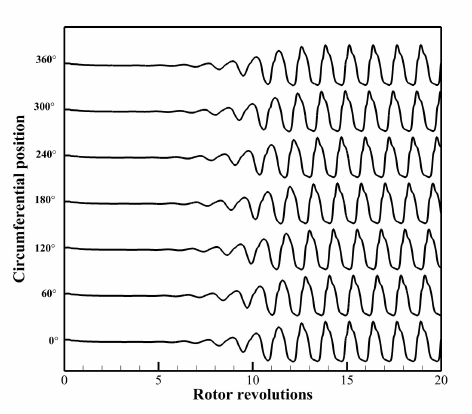
Figure 16. Dynamic process of rotating stall for the fan.